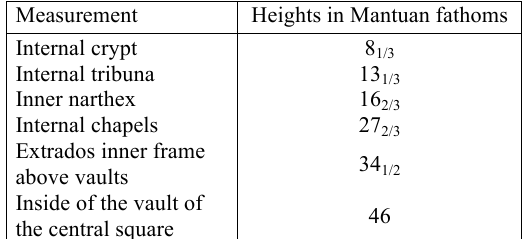
Figure 3: Comparative analysis on the heights gathered by a cross section of the point cloud (original drawings scale 1: 100). Double check of Labacco’s drawings by the use of a BIM model built by the point cloud.